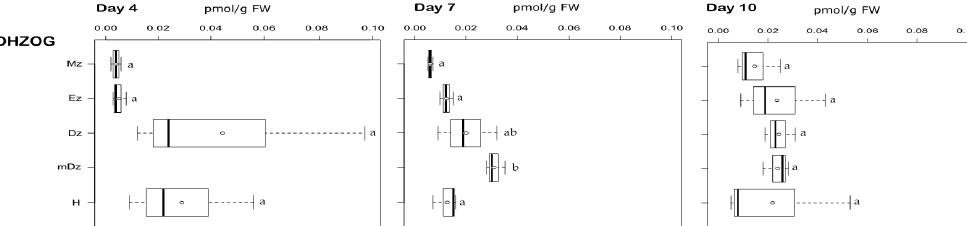
Figure 5. Quantification of DHZ-type cytokinins in hypocotyl and developmental root sections of cacao seedlings. Levels of dihydrozeatin- O -glucoside (DHZOG) were determined from the samples described in Figure 1. The levels of dihydrozeatin (DHZ), dihydrozeatin riboside (DHZR), dihydrozeatin riboside-5 ′ -monophosphate (DHZRMP), dihydrozeatin riboside- O -glucoside (DHZROG), dihydrozeatin-7-glucoside (DHZ7G), and dihydrozeatin-9-glucoside (DHZ9G) were below the limit of detection in all samples. The dark vertical line indicates median; boxes represent 25th and 75th percentiles; horizontal lines represent maximum and minimum values; circles indicate mean values. Significant variations in concentration determined by Welch’s test post hoc, p ≤ 0.05 among hypocotyl and primary root sections are indicated by letters, n = 3 independent biological replicates; FW = fresh weight.